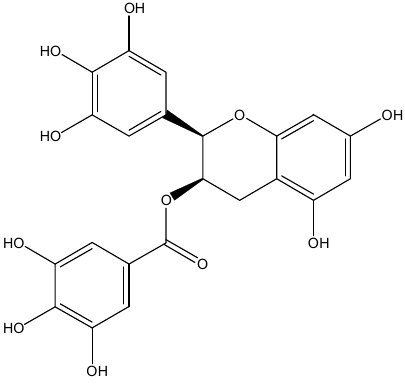
Figure 3. The chemical structure of EGCG.